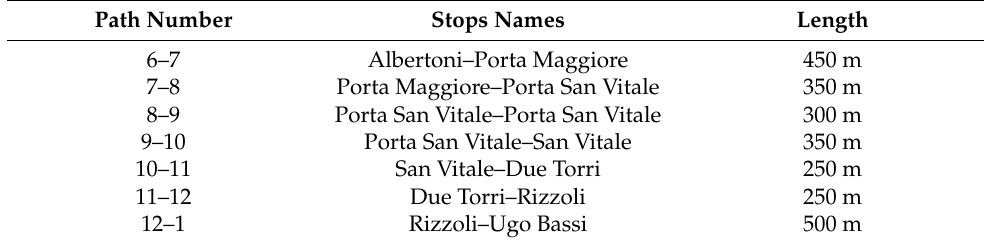
Table 4. Line 15—Return journey. Names of the trolleybuses’